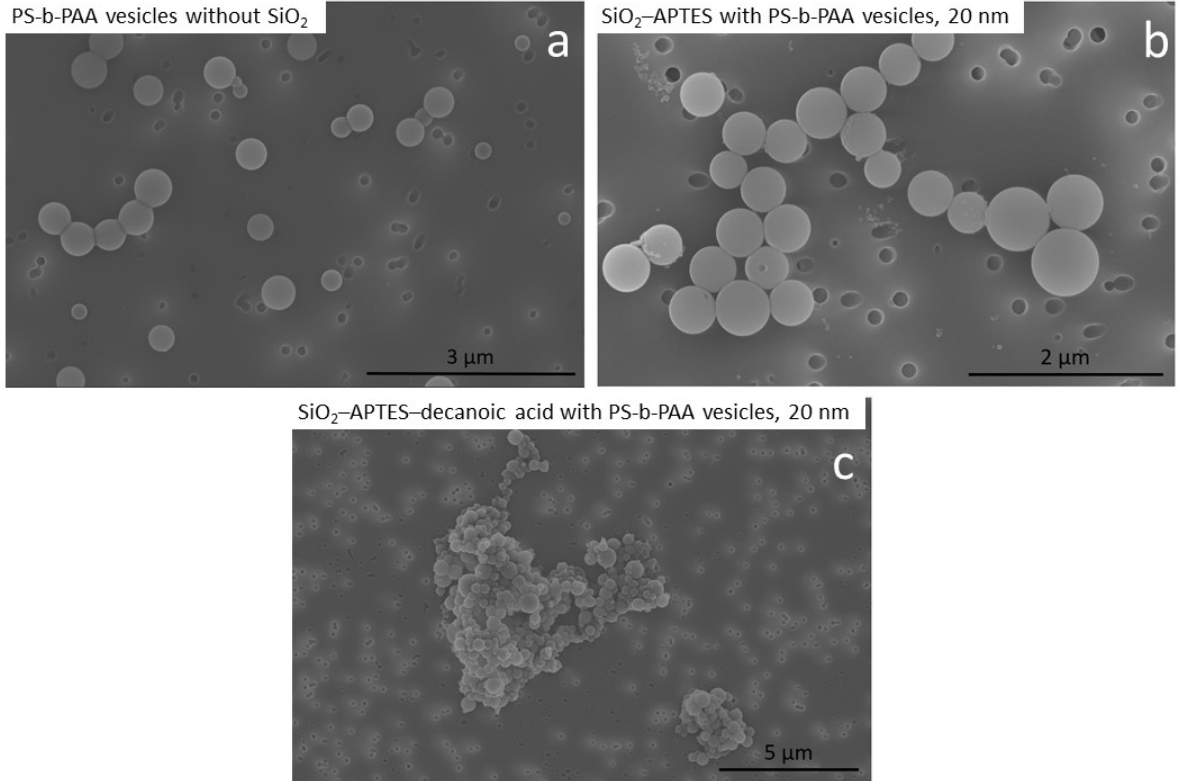
Figure 10. SEM images of the encapsulation experiments of silica nanoparticles in PS-b-PAA vesicles. ( a ) Encapsulation experiment with PS-b-PAA vesicles without SiO 2 as a reference. ( b ) Encapsulation experiment with SiO 2 –APTES (20 nm). ( c ) Encapsulation experiment with SiO 2 –APTES–decanoic acid (20 nm).